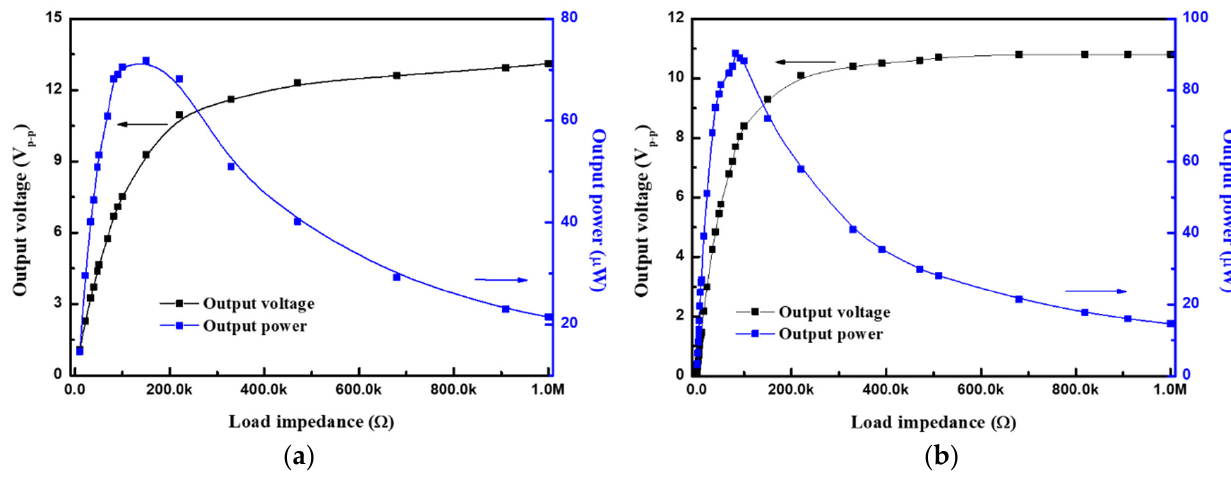
Figure 8. Frequency dispersion of permittivity and loss tangent of the 600 °C annealed PMN–PT film.